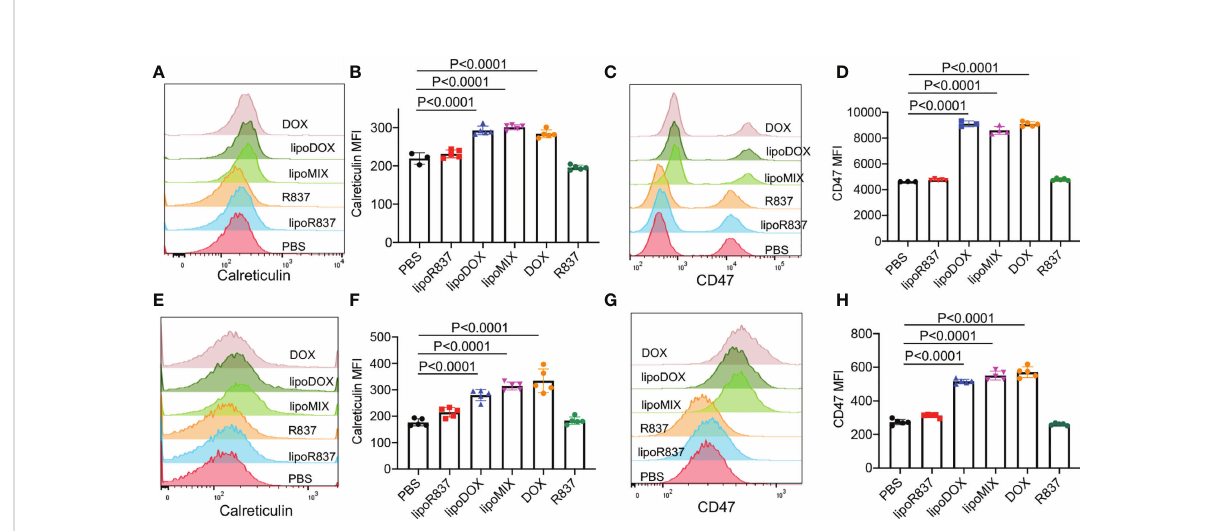
FIGURE 3 Dox-loaded liposomes can induce the immunogenic death of cancer cells. 4T1 breast cancer cells (A – D) or B16F10 melanoma (E – H) were incubated with free Dox, Dox-loaded liposomes (lipoDox), Dox/R837-loaded liposomes (lipoMix), R837-loaded liposomes (lipoR837), free R837, or PBS for 16 h, followed by staining with anti-CD47 and anti-calreticulin prior to fl ow cytometry analysis. The concentration of Dox and R837 was set at 500 and 330 nM, respectively. (A) Representative calreticulin histograms and (B) mean calreticulin fl uorescence intensity of 4T1 cells after different treatments. Also shown are (C) representative CD47 histograms and (D) mean CD47 fl uorescence intensity of 4T1 cells after different treatments. (E) Representative calreticulin histograms and (F) mean calreticulin fl uorescence intensity of B16F10 cells after different treatments. Also shown are (G) representative CD47 histograms and (H) mean CD47 fl uorescence intensity of B16F10 cells after different treatments. All the numerical data are presented as mean ±